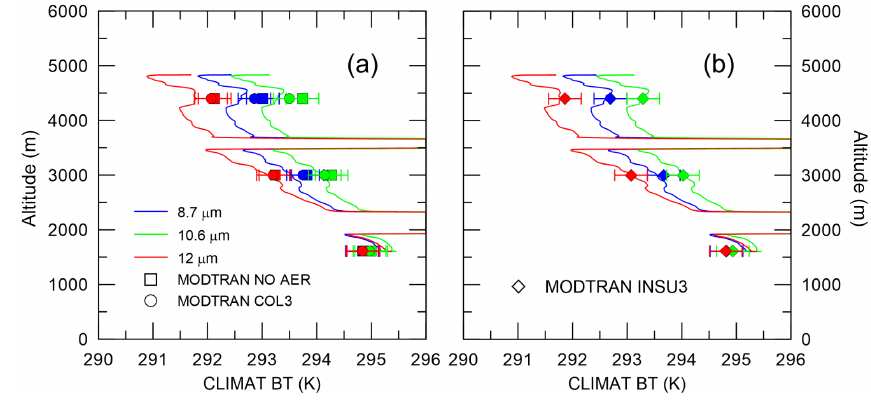
Figure 11. Same as Fig. 9, but for profile F42. Simulated data are for the in situ PSD and Tunisian and Moroccan dust RIs in (b) .